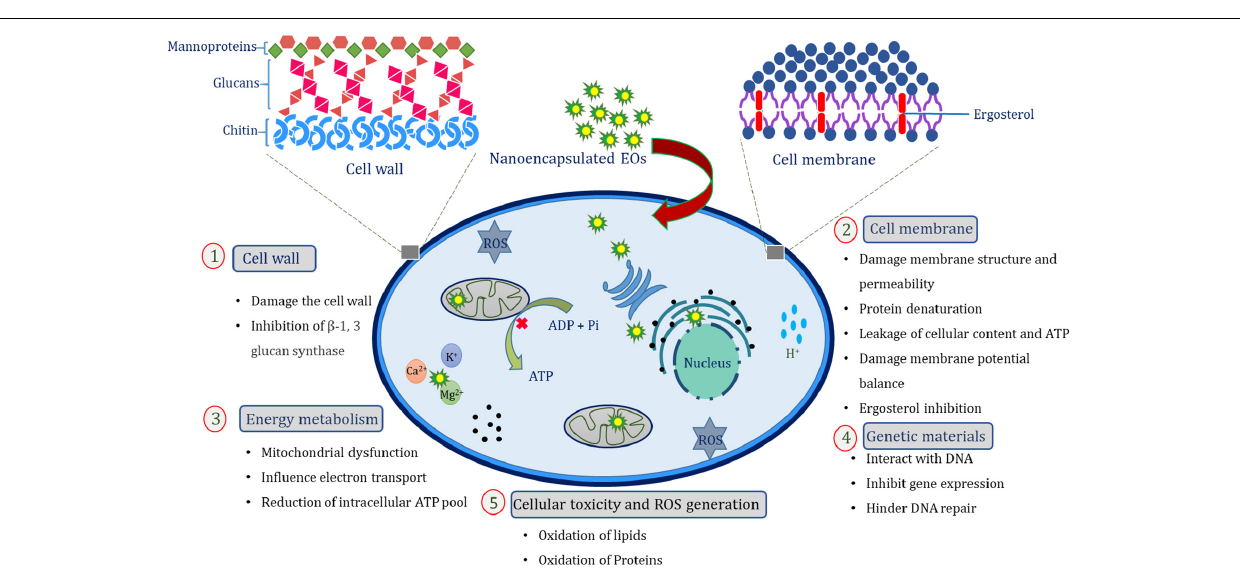
FIGURE 2 | Schematic representation of possible antifungal mechanisms of action of EO